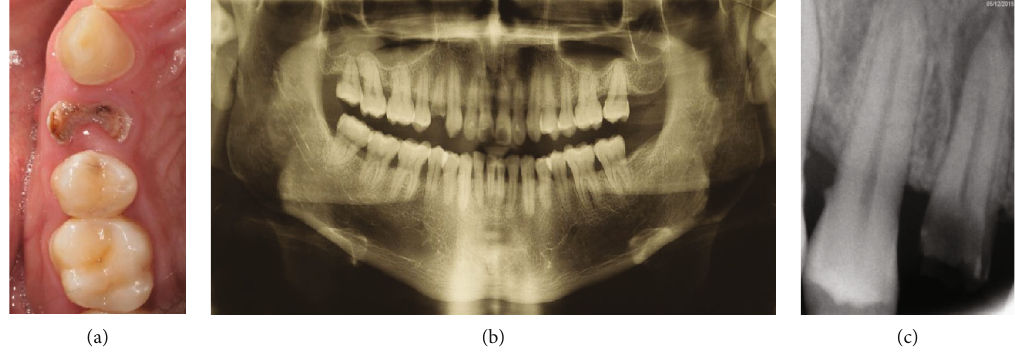
Figure 1: (a) Preoperative occlusal view; (b) orthopantomography; (c) preoperative periapical